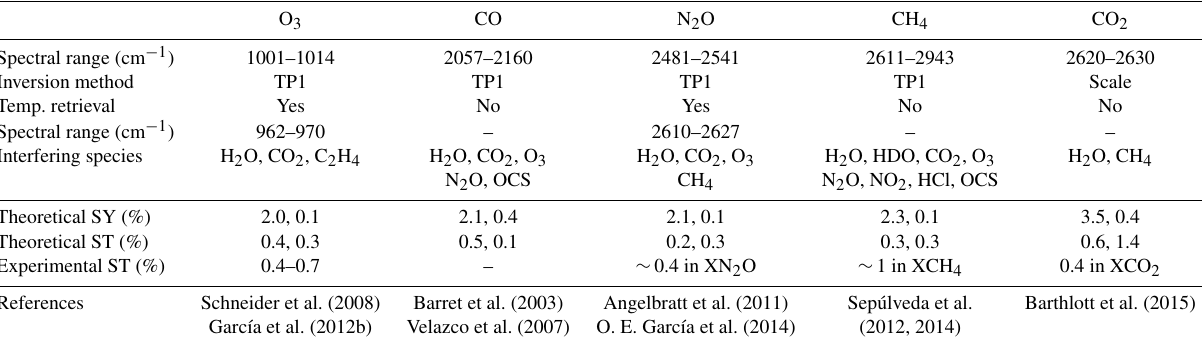
Table 3. Description of the FTS retrieval setups used in this work. The profile retrieval is done by using a Tikhonov–Phillips slope constraint (TP1), while the scale retrieval corresponds to a scale to the a priori VMR profile. A summary of the error estimation is also provided: theoretical total systematic (SY) and statistical (ST) errors for the FTS total column products (median, 1 σ × 10 − 1 , being σ the standard deviation of the error distributions between 2010 and 2014). XN 2 O, XCH 4 , and XCO 2 correspond to the total column-averaged dry air mole fractions of N 2 O, CH 4 , and CO 2 respectively. O 3 CO N 2